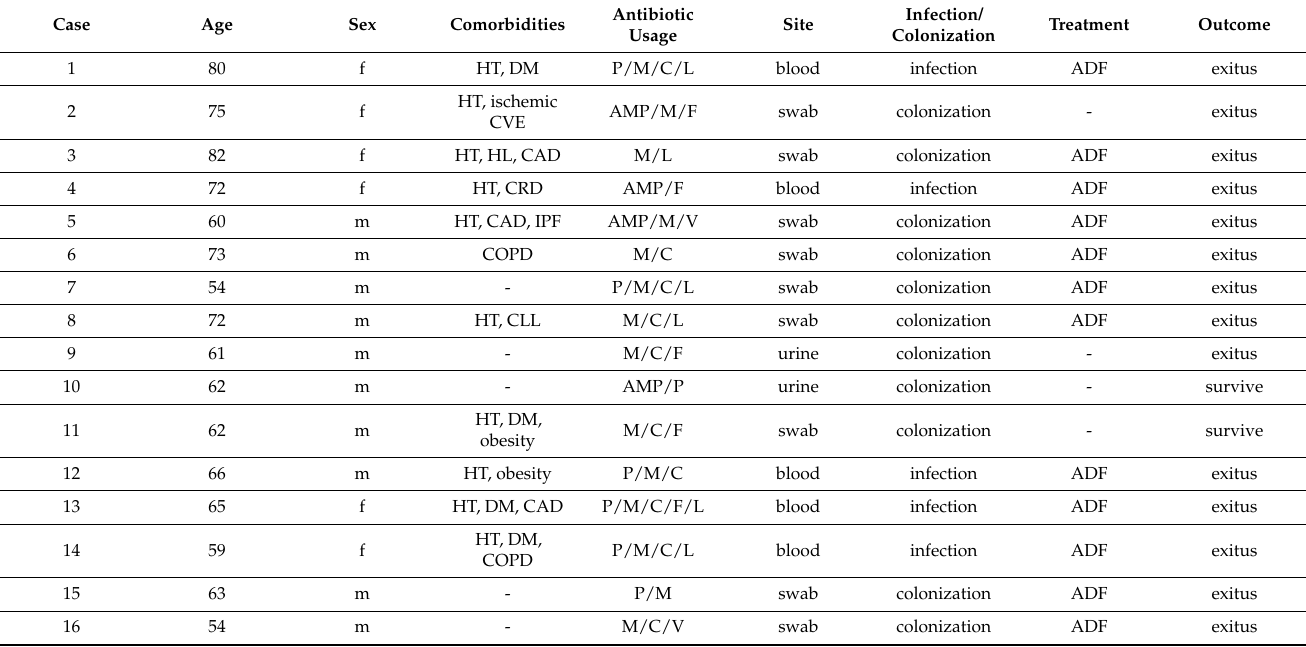
Table 1. Characteristics of